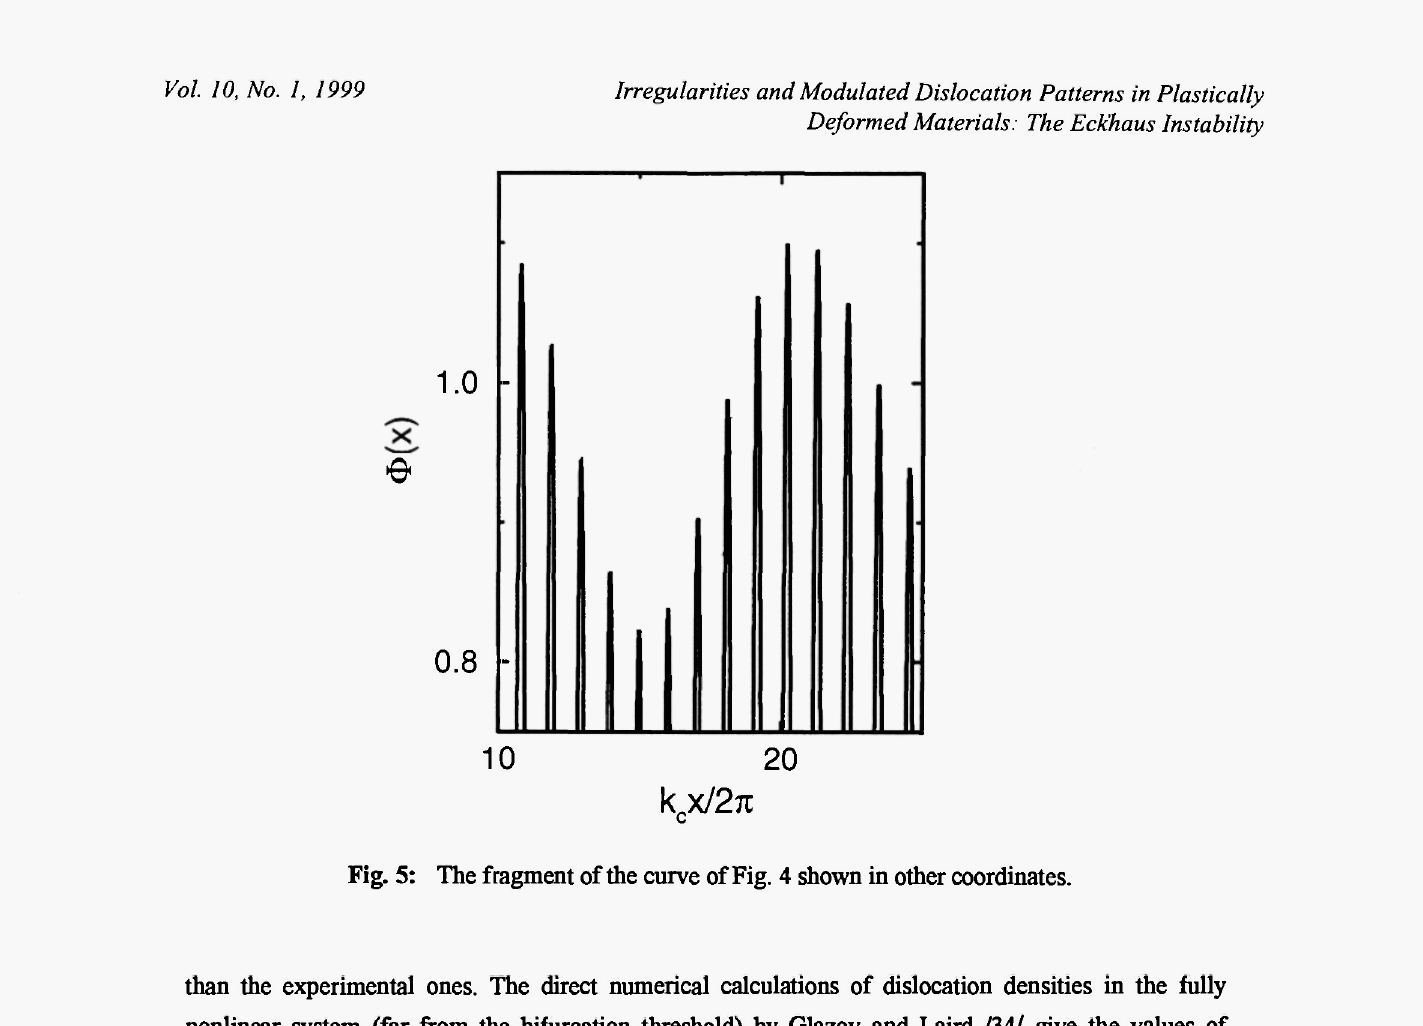
Fig. 5: The fragment of the curve of Fig. 4 shown in other